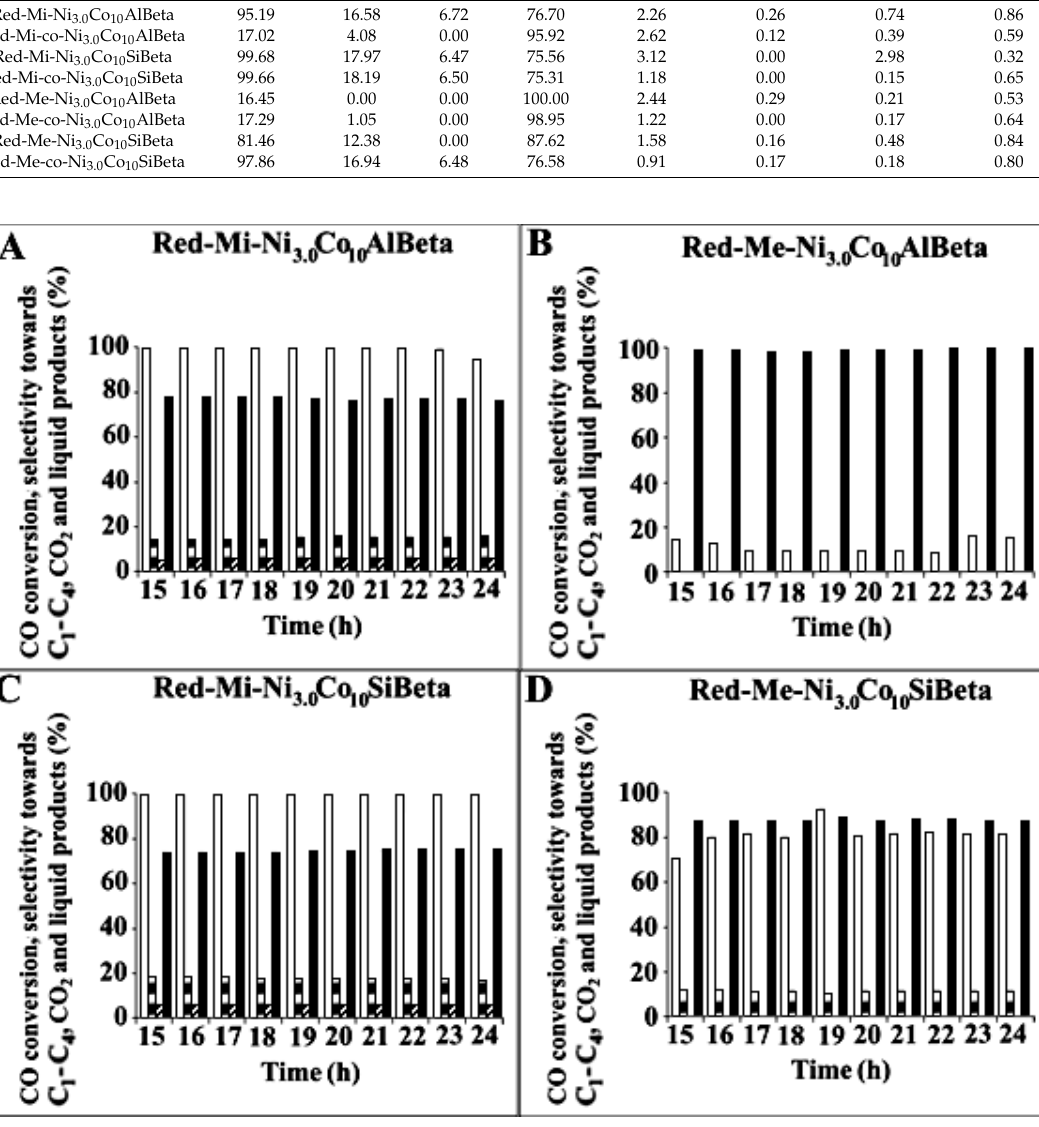
Figure 8. Conversion of CO ( ) and selectivity to C 1 -C 4 ( ), CO 2 ( ) and liquid products ( ) after Fischer–Tropsch synthesis (T = 260 °C, p = 30 atm, t = 24 h) over ( A ) Red-Mi-Ni 3.0 Co 10 AlBeta, ( B ) Red-Me-Ni 3.0 Co 10 AlBeta, ( C ) Red-Mi-Ni 3.0 Co 10 SiBeta, ( D ) Red-Me-Ni 3.0 Co 10 SiBeta.